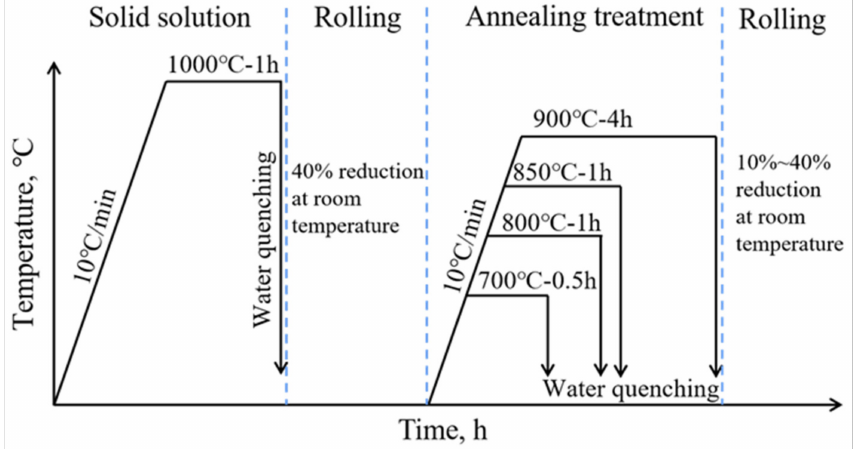
Figure 2. The schematic diagram of experimental